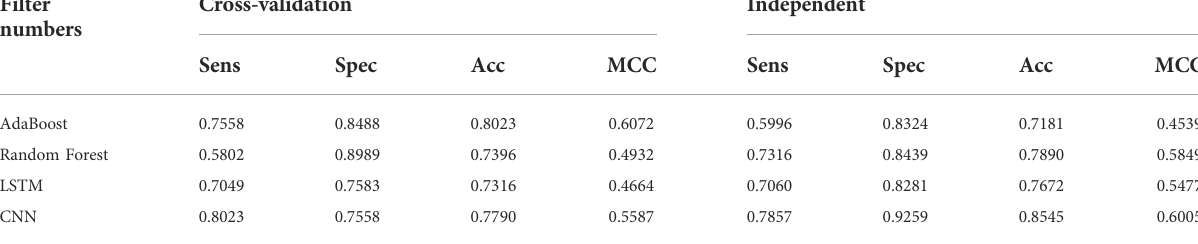
TABLE 6 DDE model performance results of identifying UPP with fi lter numbers. Filter